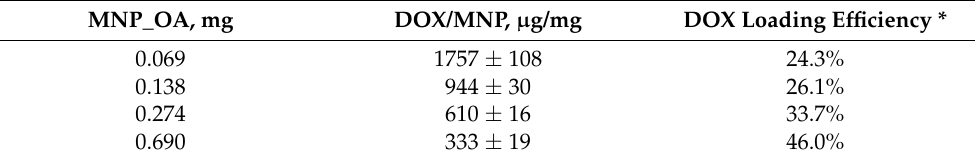
Table 4. DOX loading MNP_OA capacity in sodium borate buffer (SBB, 10 mM, pH 8.5).